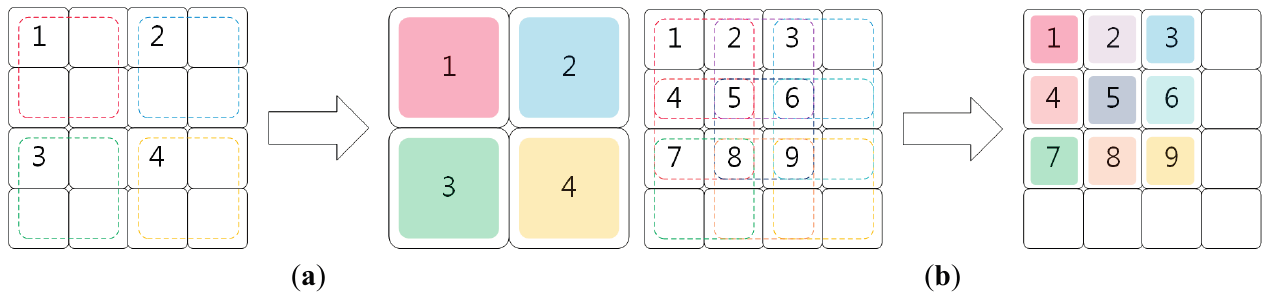
Figure 1. Two different pixel binning approaches to combine 2 × 2 pixels into one bin: ( a ) sensor-based pixel binning; and ( b ) digital pixel